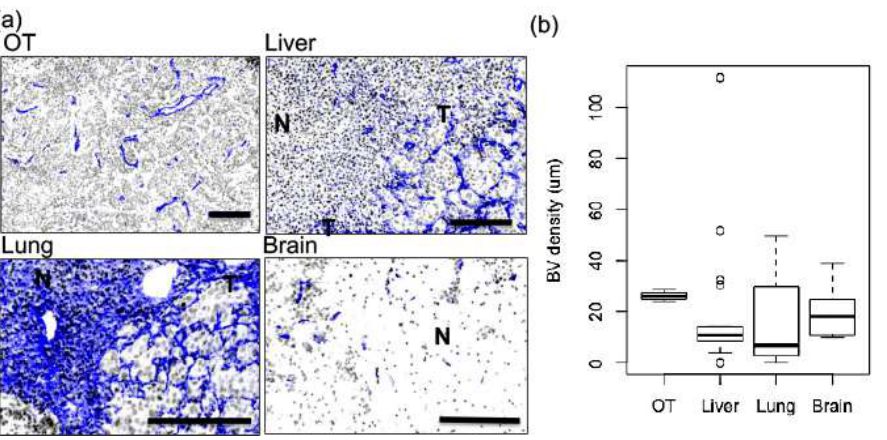
Figure 7. Vascular architecture and density show significant intra-tumoral and inter-metastatic heterogeneity. To examine vascular density, tissue sections were stained with Hoechst (grey) and CD31 (blue). The size and structures of blood vessels are shown in representative lesions from orthotopic tumors, lung, liver, and brain ( a ). Differences in vascular architecture can be appreciated between lesions (T), as well as between lesions (T) and their respective adjacent normal tissues (N). Bar = 100 µ m. Vascular density was calculated using an automated algorithm that calculates the average distance of any given pixel in a region of interest to a CD31-positive pixel. The vascular density for each lesion was plotted as a box and whisker plot to illustrate the variability, and a Kruskal–Wallis test did not provide a statistically significant p -value (0.1983) ( b ). Vascular density was determined based on the average distance between a nuclei and its nearest CD31-stained object in an overlayed image and was plotted as a box and whisker plot to illustrate the variability of tumor blood vessel density in different organs as well as the range in densities found in metastases of the same organ (Figure 7b). Orthotopic tumors show the tightest distribution, while lesions of the liver, lung, and brain illustrate considerably more